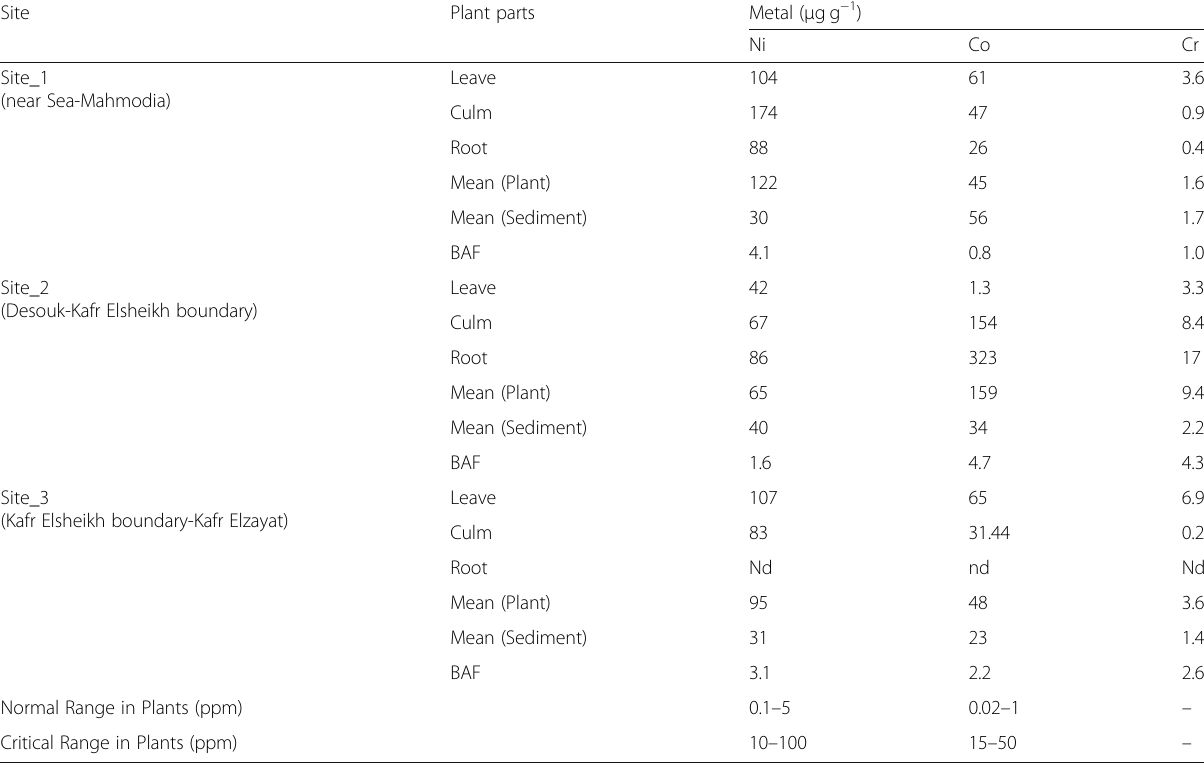
Table 4 Concentrations of heavy metals in leave, culm, and roots of P. australis within sites of the study area compared with normal and critical ranges in plants [31] and Bioaccumulation Factor of the plant (BAF)